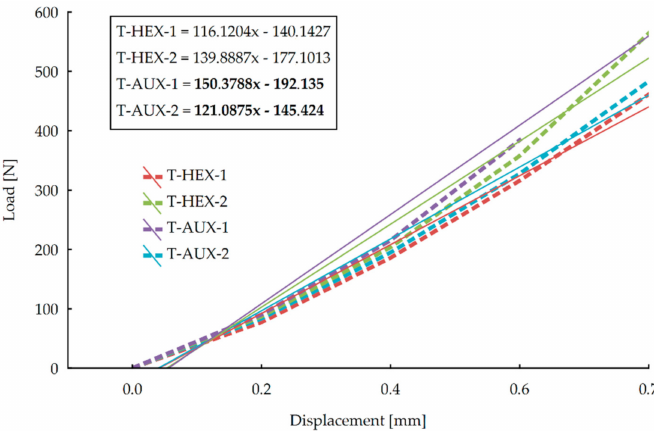
Figure 8. Sti ff ness of joints in tension test in the linear elasticity range.